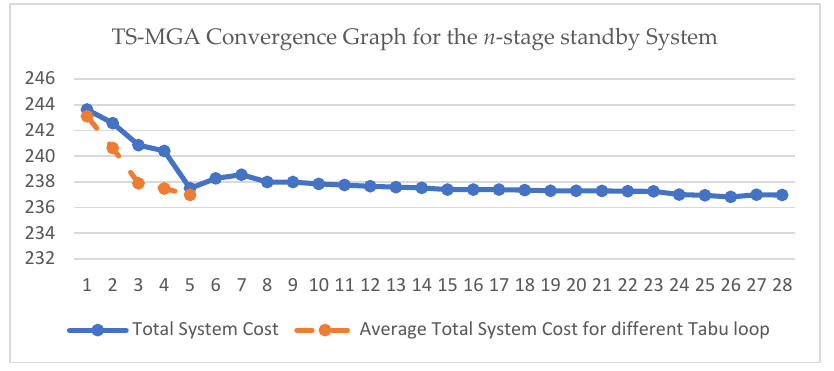
Figure 4. The convergence graph of n -stage standby system by conducting TS-MGA combined method.